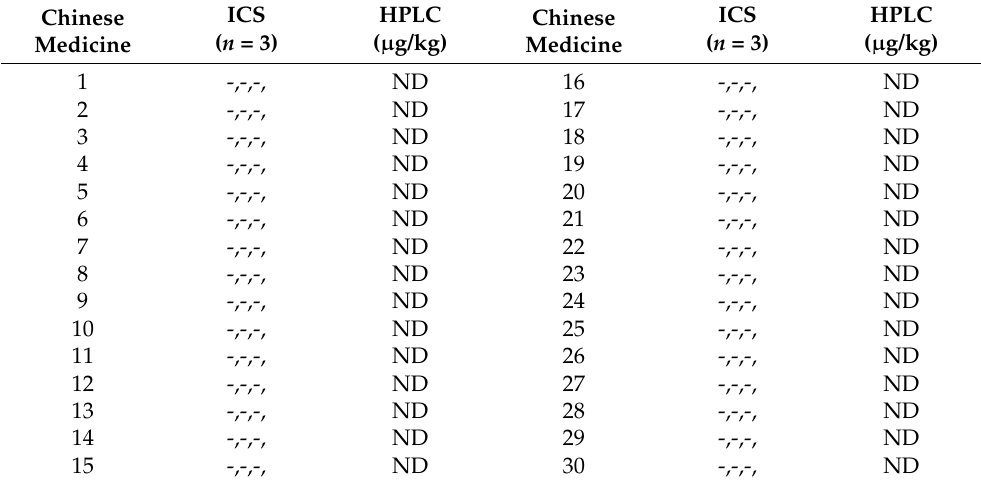
Table 1. ICS and ELISA detection results of ZEN in traditional Chinese medicine samples.